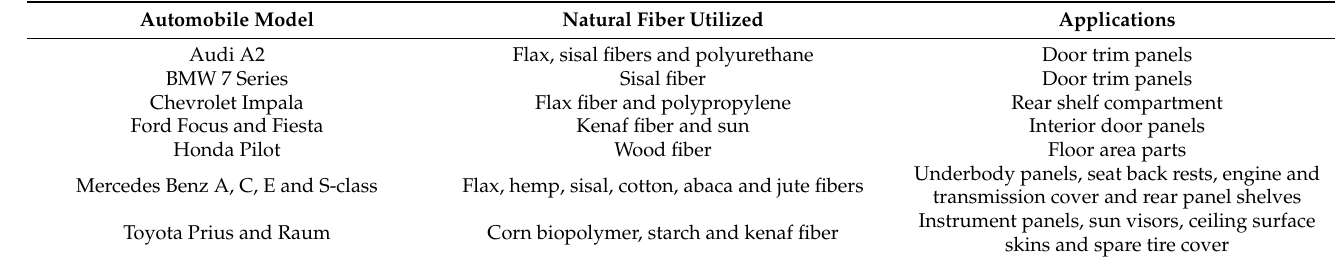
Table 4. Lists of natural fibers reinforced hybrid composites currently being used in the automotive industry. Extracted from Ref. [308] with